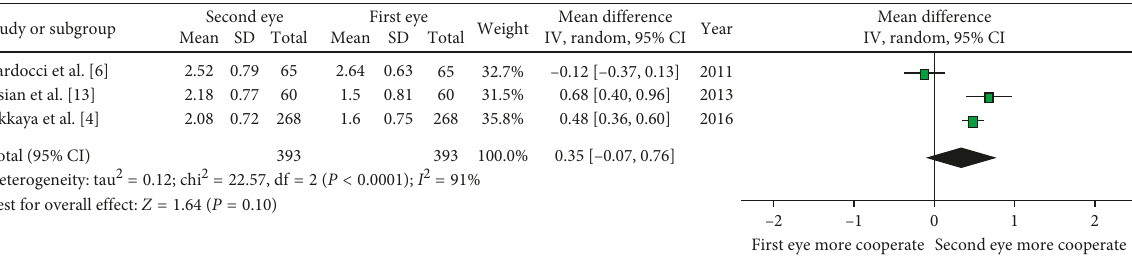
Figure 6: Forest plot comparing the cooperation of patients.